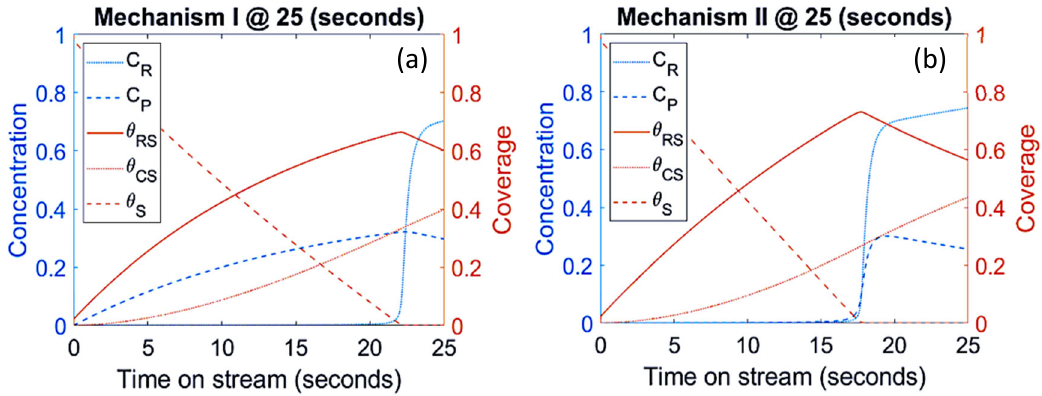
Figure 3. Estimated reactant and product concentration profiles ( left axis ) and surface species coverages ( right axis ) with respect to time: comparison between mechanism I ( a ) and and mechanism II ( b ).